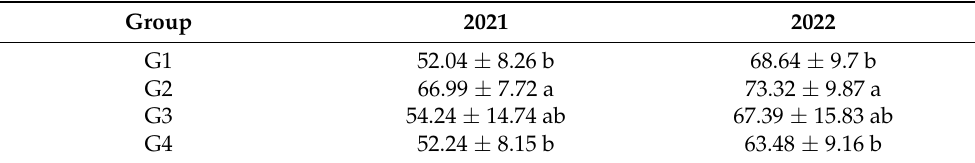
Table 6. Evaluation of the in vivo viability of pollen from four different sources, expressed as a fruit set